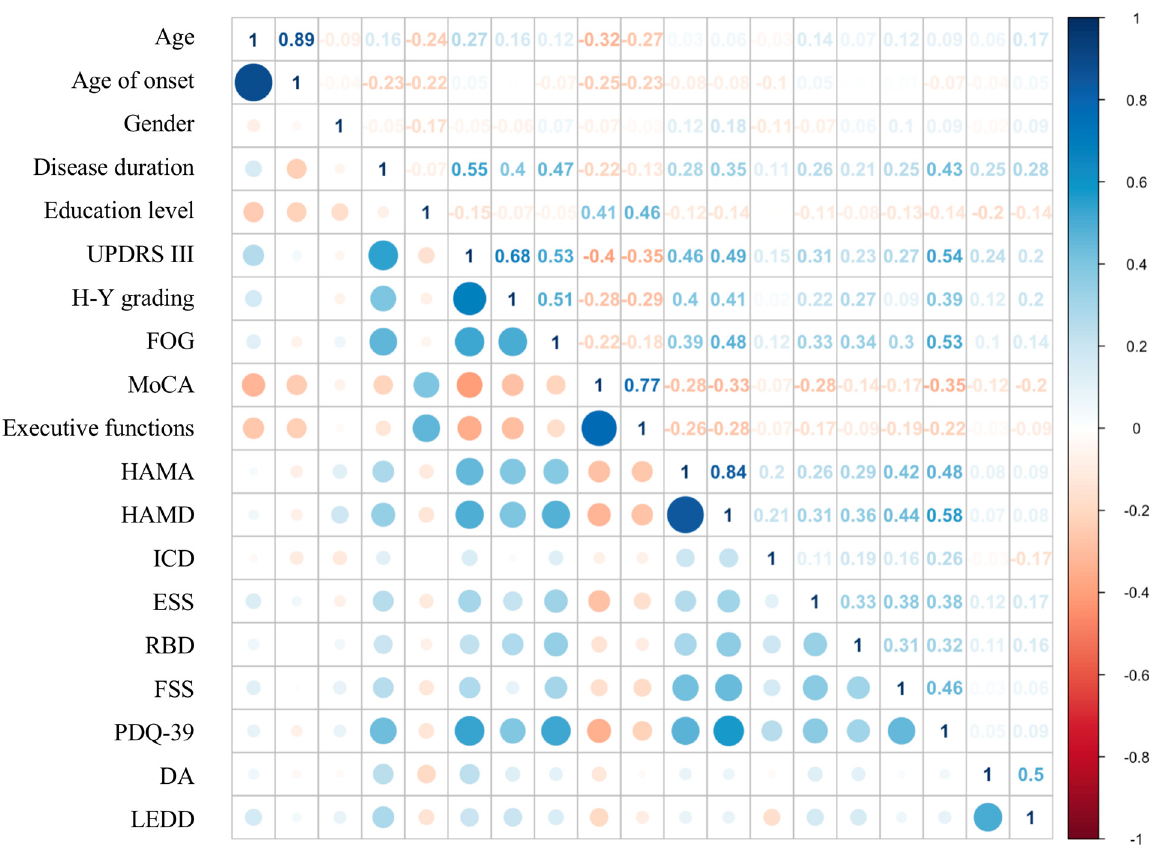
Figure 2. Correlation